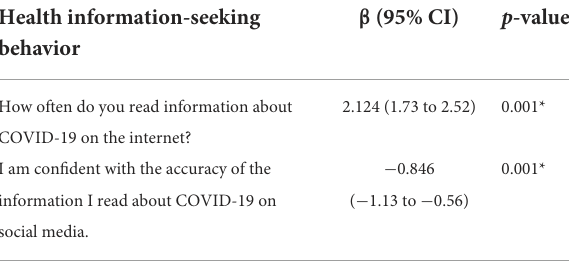
TABLE 6 Multivariate linear regression model for overall DHL and health information seeking behavior adjusted for covariates ( n =